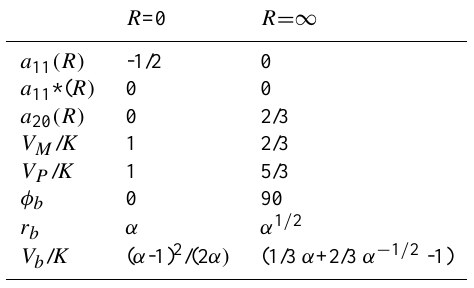
Table 2. The model threshold parameters at the spin limits.